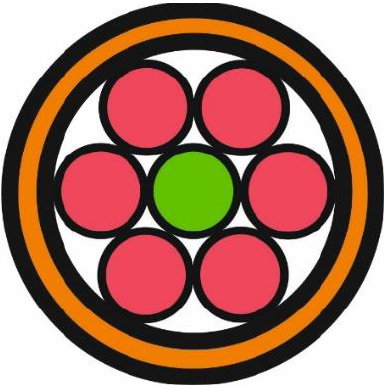
Figure 4. Scheme of a 1-to-7 fun-out fibre-optic bundle in a round-end configuration. The central core of the fan-out (green colour) transfers a back-reflected signal form the measuring head to the photodetector, while other cores (red colour) illuminate the tested sample. The critical point of the measurement is the adjustment of the collimating lens and the output of the fan-out. The performance of the measuring head was tested with and without an achromatic collimator. Due to the use of the LEDs generating a very broad spectrum, fibres with a relatively large core diameter and the fibres location in spaces in a round-end configuration, differences in illumination areas for different sources, such as size and location, were expected. The main problem was illuminating the spot evenly on the sample from which the signal was reflected. Therefore, the performance of the measuring head with and without a collimator was tested in a laboratory setup as is presented in Figure 5. During the calibration procedure, a white ping-pong ball with a rough and clear white surface was used instead of a tested object. This allows for the adjustment of the light intensities in all of the spectral channels accurately. The tested objects (eggshells and a calibration ball) were partially transparent; therefore, the use of an overhead cover/shade was necessary for limiting the influence of external parasitic light on the measurements.